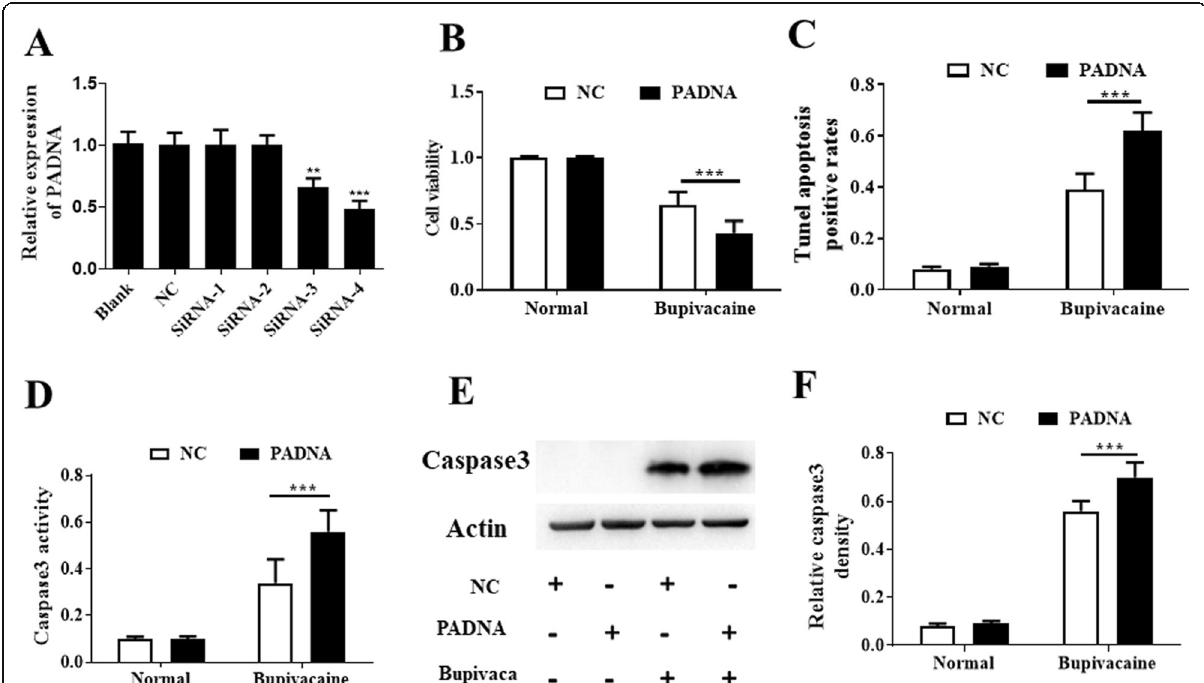
Fig. 2 Function of lincRNA PADNA in bupivacaine-induced neurotoxicity. a The expressions of lincRNA PADNA were significantly decreased in DRG neurons treated with siRNA3 or siRNA4 when compared with blank group, NC group, DRG neurons treated with siRNA1 or siRNA2. b Cell viability was significantly decreased in DRG neurons treated with knockdown vector of lincRNA PADNA. Cells were treated with 1 mM bupivacaine. c Percentage of apoptotic of cells was significantly increased in DRG neurons treated with knockdown vector of lincRNA PADNA. Cells were treated with 1 mM bupivacaine. d Caspase3 activity was significantly increased in DRG neurons treated with knockdown vector of lincRNA PADNA. Cells were treated with 1 mM bupivacaine. e , f The expression of Caspase3 protein was significantly increased in DRG neurons treated with knockdown vector of lincRNA PADNA. Cells were treated with 1 mM bupivacaine. Data are Mean ± SD with n = 3 independent biological cultures. * p < 0.05 and ** p <